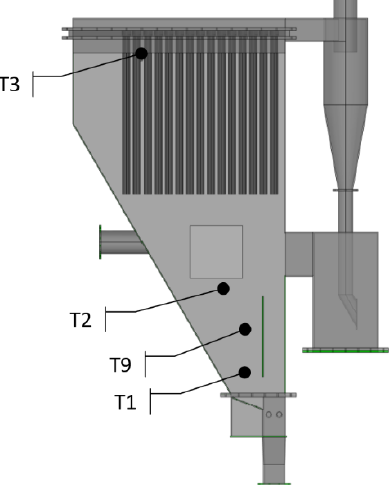
Figure 2. Schematic of the bubbling fluidized bed gasifier with the ceramic candles housed in the freeboard. The positioning of the four main thermocouples for measuring the temperature inside the gasifier (i.e., T1, T2, T3, and T9) is shown. The HT filtration system consisted of sixty ceramic candles arranged in five clusters of twelve elements each. To monitor the temperature along the gasifier, several thermocouples were installed in the most relevant internal areas, as indicated in Figure 2. Specifically, two thermocouples were located inside the bed inventory, one in the freeboard in contact to the fluidized bed material and another one in the upper part of the gasifier near the ceramic candles.